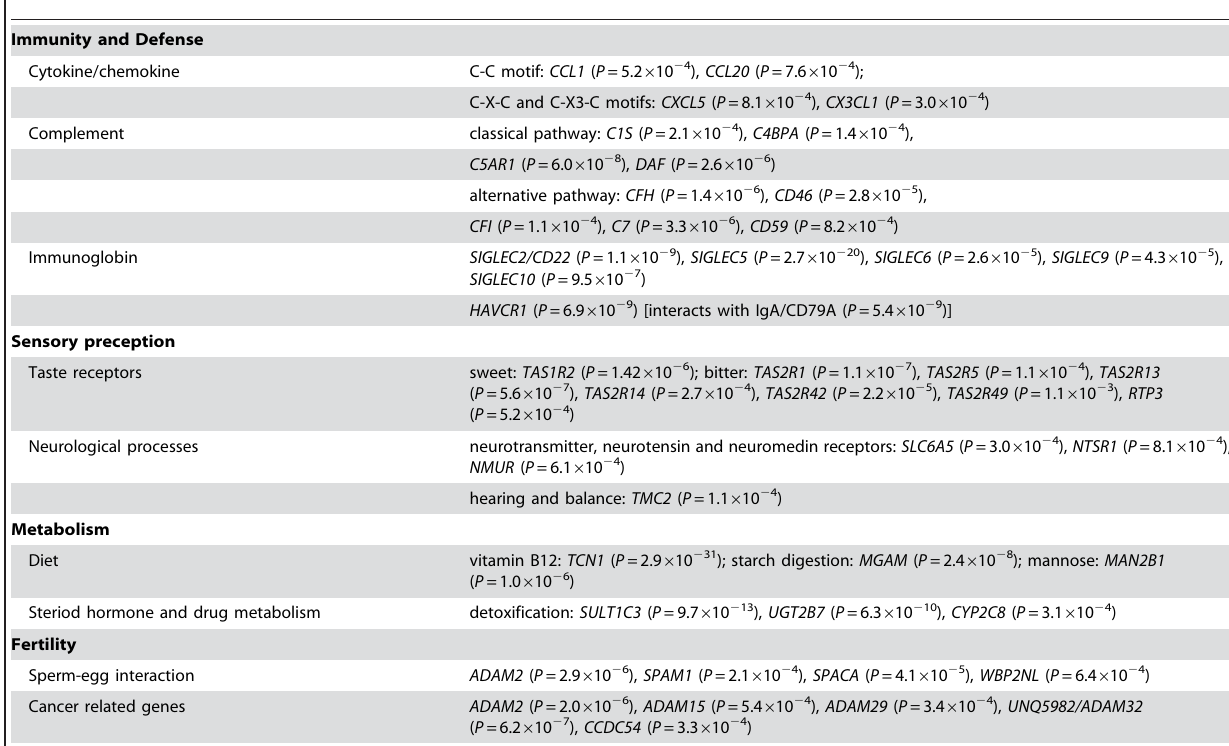
Table 3. Summary of individual PSGs discussed in this article.